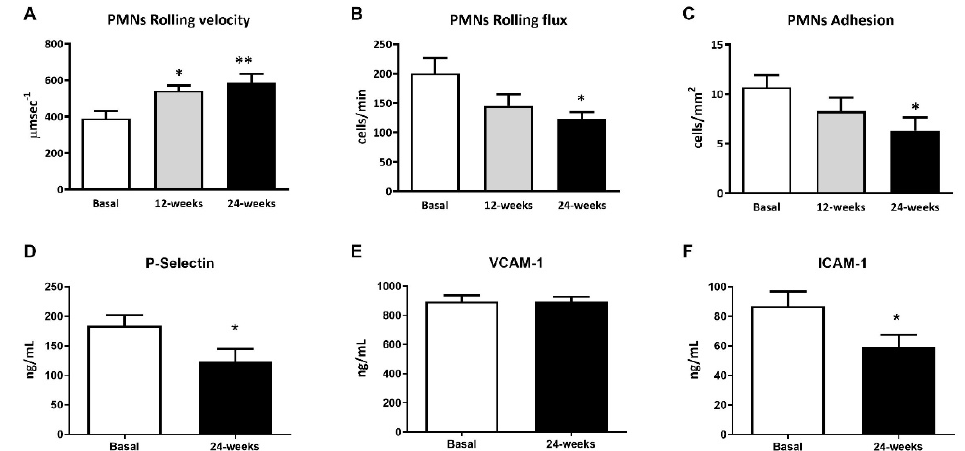
Figure 1. Effects of empagliflozin treatment on leukocyte–endothelium interactions and serum soluble cell adhesion molecules in type 2 diabetic patients at baseline and at 12 and 24 weeks of treatment. ( A ) Leukocyte rolling velocity ( μ m·sec − 1 ), ( B ) rolling flux (cells/min), ( C ) leukocyte adhesion (cells/mm 2 ), ( D ) P-Selectin levels (ng/mL), ( E ) VCAM-1 levels (ng/mL), ( F ) ICAM-1 levels (ng/mL). For leukocyte–endothelium interactions, an ANOVA followed by Dunnett’s multiple comparisons test was performed. For serum soluble cell adhesion molecules, Student’s t-test was performed. * p < 0.05 and ** p < 0.01 vs. baseline. Data are expressed as mean ± SEM. Abbreviations: PMN, polymorphonuclear leukocytes; ICAM-1, intercellular adhesion molecule-1; P-Selectin, platelet selectin; VCAM-1, vascular cell adhesion molecule-1.